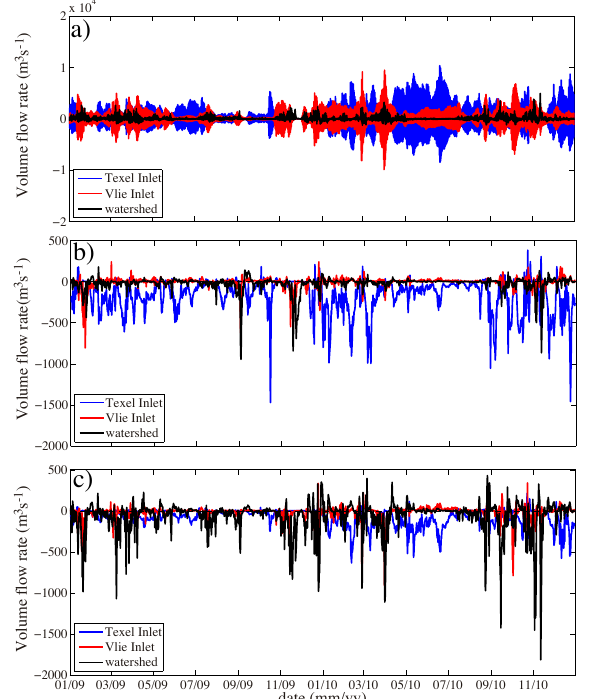
Figure 18. (a) Time series of the instantaneous volume flow rate of the tracer corresponding to water from Kornwerderzand at the Texel Inlet, the Vlie Inlet, and the Terschelling watershed. The temporal resolution is 30min. (b) Tidally averaged volume flow rate of fresh water from Den Oever through the Texel Inlet, the Vlie Inlet and across the Terschelling watershed. (c) Tidally averaged volume flow rate of fresh water from Kornwerderzand through the Texel Inlet, the Vlie Inlet and across the Terschelling